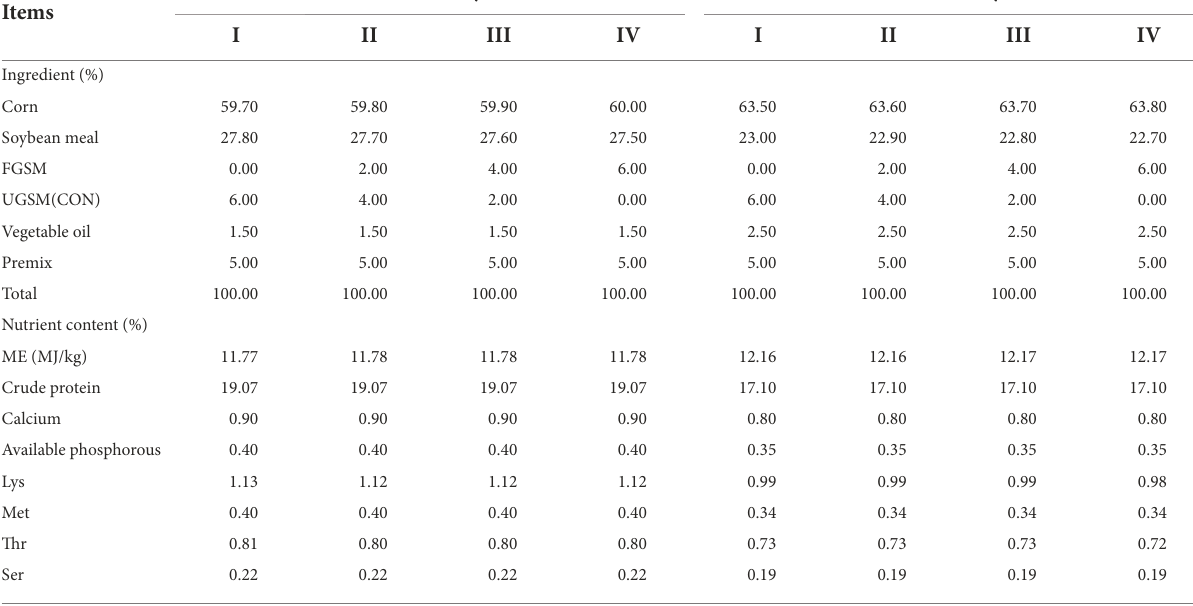
TABLE 1 Composition and nutrient levels of diets